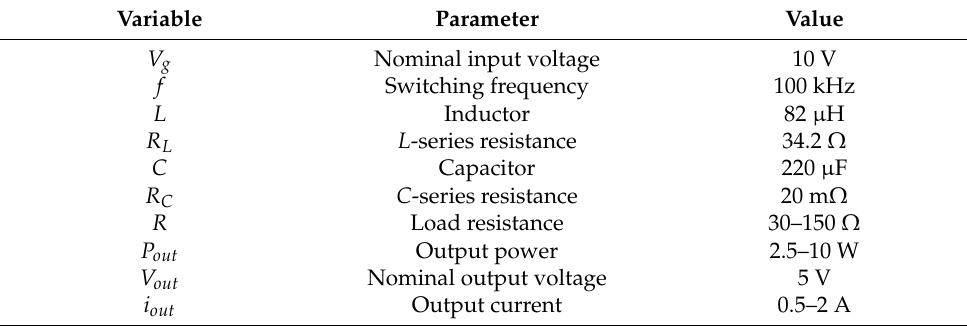
Table 5. Buck converter optimized for the case